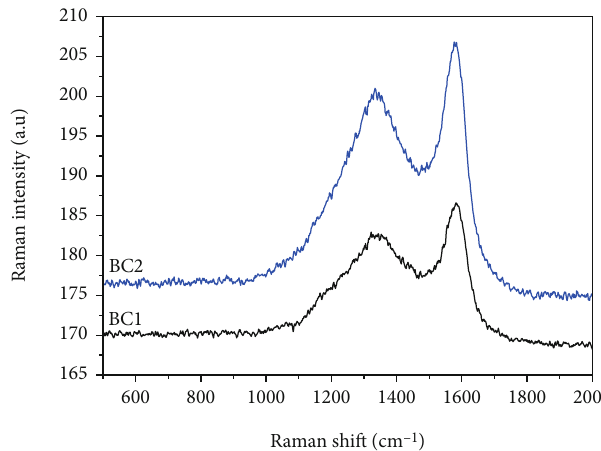
Figure 6: Raman spectrum of di ff erence BCs.